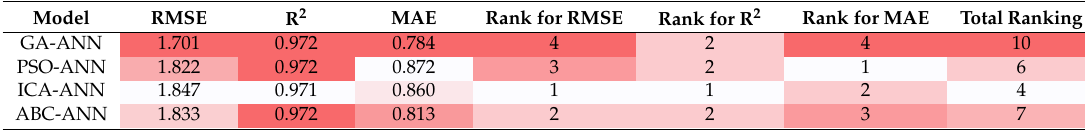
Table 2. Prediction results of the hybrid models and their performance (for the training process).